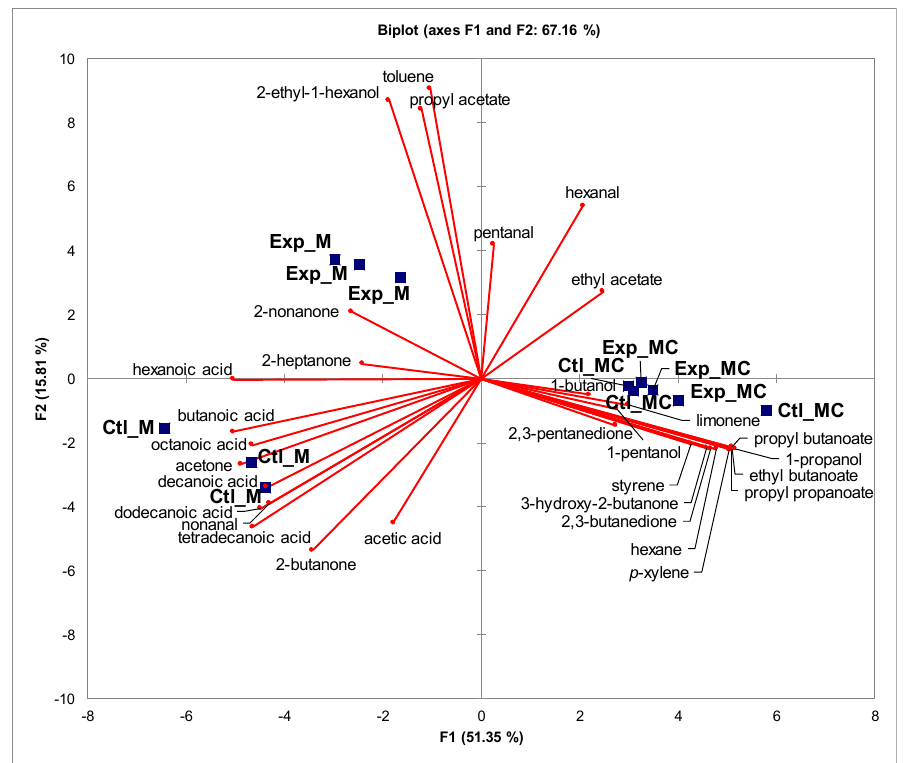
Figure 1. Principal component analysis (PCA) of volatile compounds identified in milk (M) and mozzarella cheese (MC) samples obtained from buffaloes fed total mixed ration with (Exp) or without (Ctl) fresh sorghum.